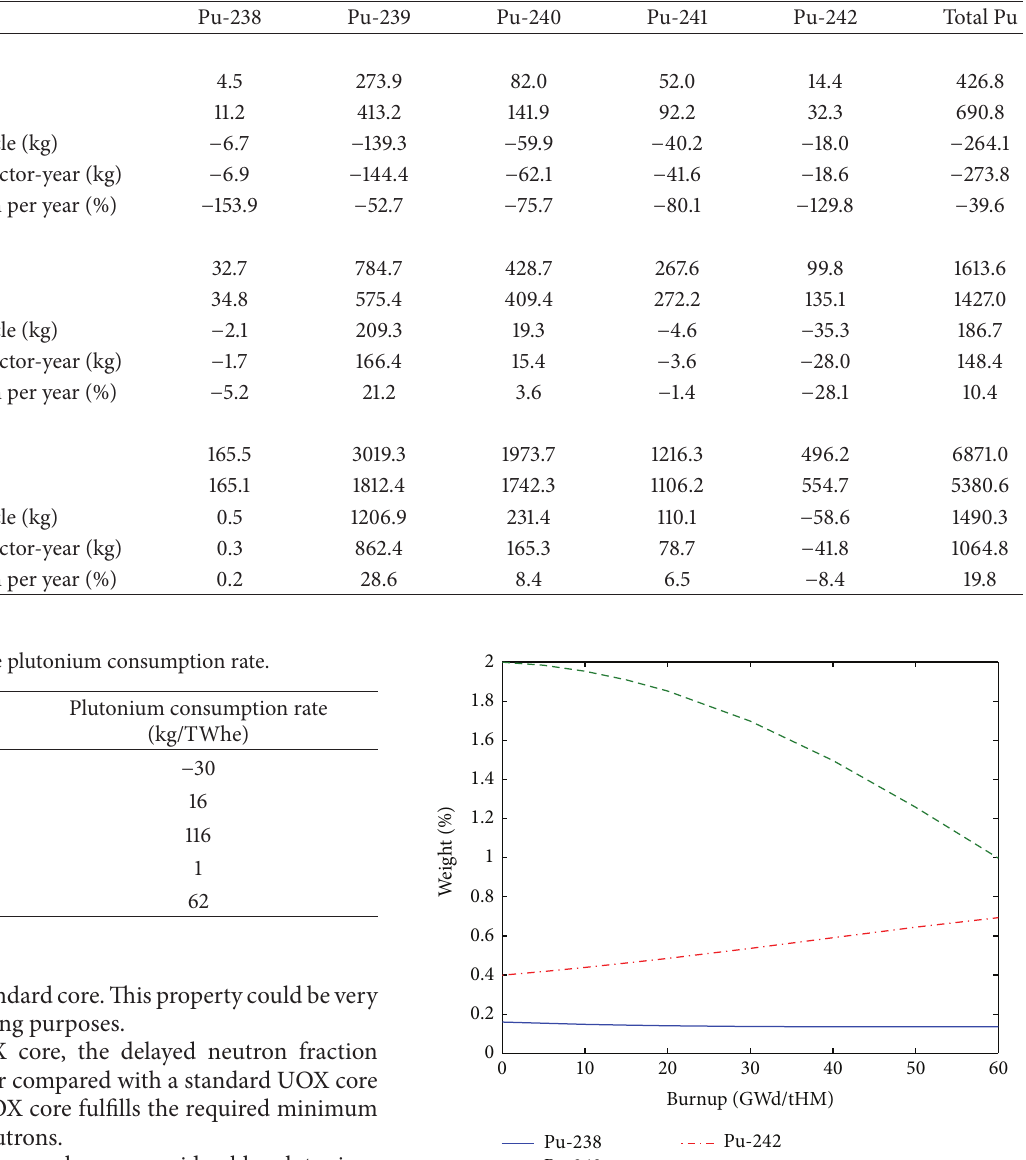
Table 5: The plutonium consumption for UOX, 1/3 Th-MOX, and full Th-MOX core.